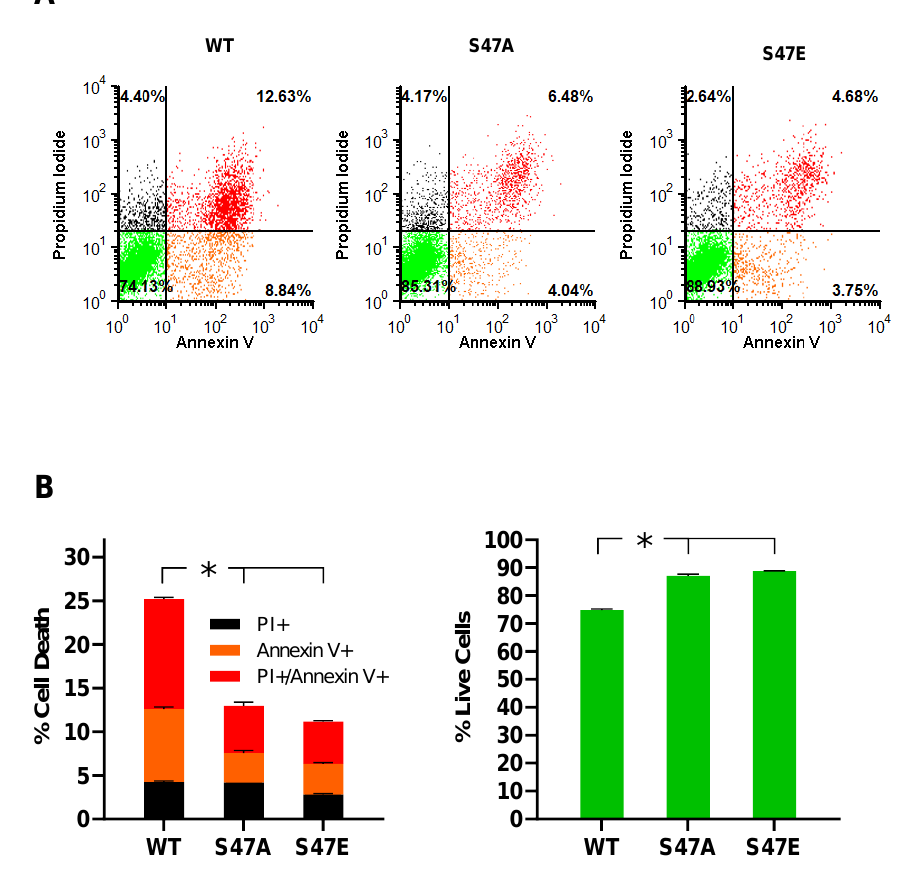
Figure 5. ( A ) Flow cytometry scatter plots representing necrotic (black, positive only for propidium iodide), early apoptotic (orange, positive only for annexin V), late apoptotic (red, double-positive for propidium iodide and annexin V), and live cells (green, unstained) in WT, S47A, S47E Cyt c expressing cells after treatment with 400 µ M H 2 O 2 for 16 h. ( B ) Cell death represented as fractions of necrotic (black), early apoptotic (orange), and late apoptotic (red) cells. Live cells, represented in the lower left quadrant in the flow cytometry scatter plots, are shown as percent of total cells ( n = 3). Data are represented by means ± SEM, * p < 0.05.